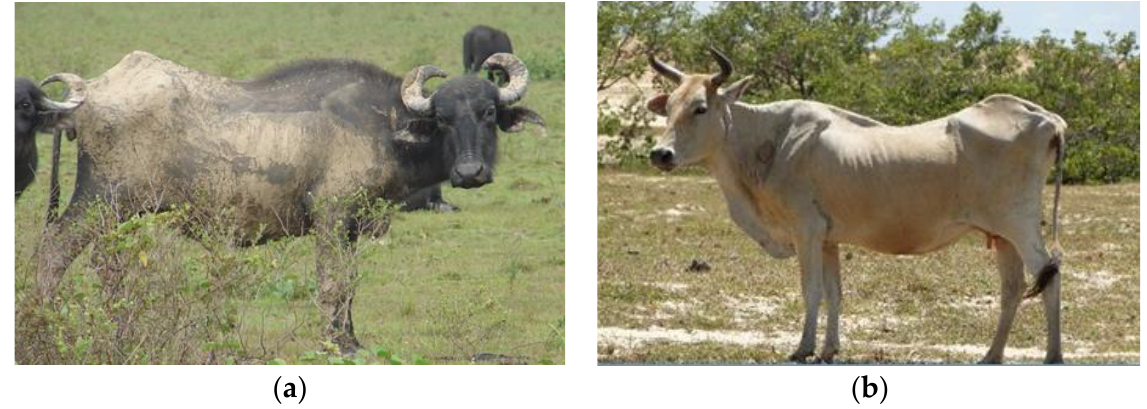
Figure 5. Clinically P-deficient buffalo cow ( a ) and crossbred cow ( b ) with severe lordosis [11,23].